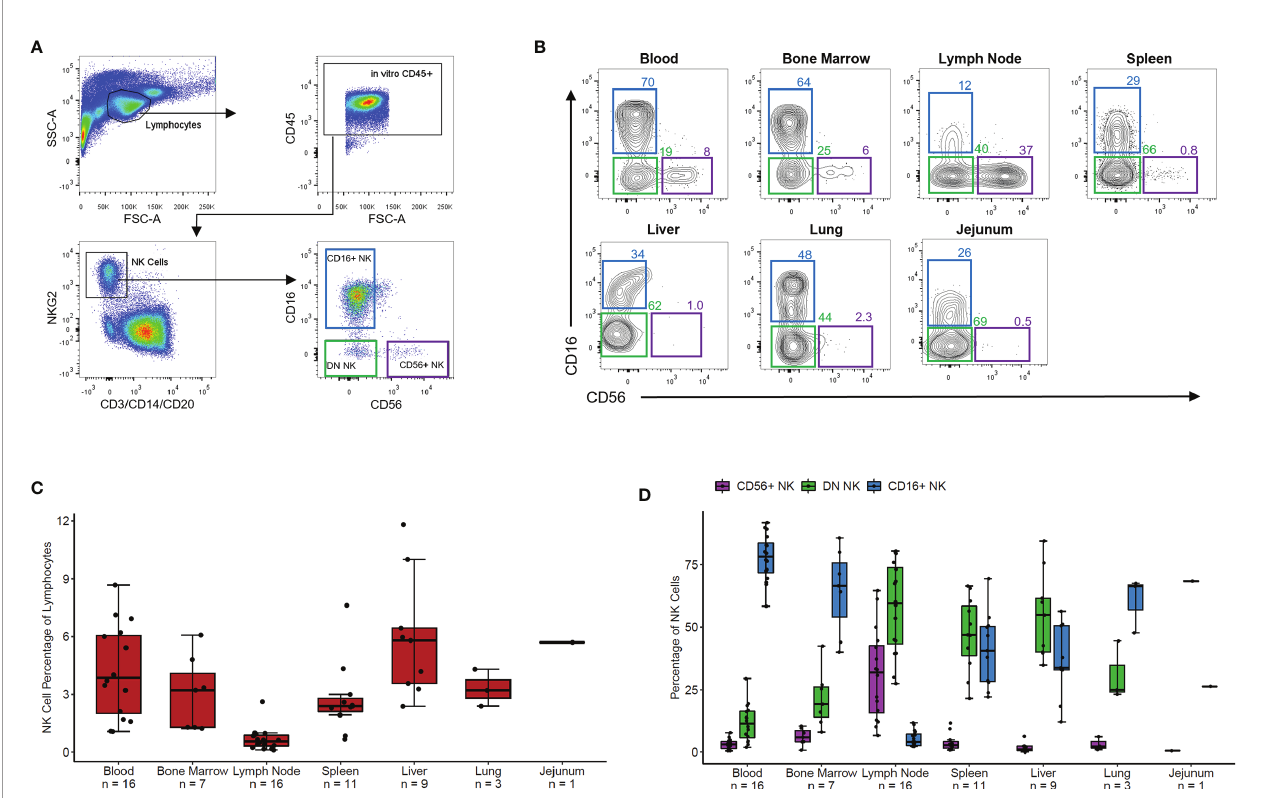
FIGURE 1 | NK phenotypes in rhesus blood and tissues. (A) Representative gating scheme of rhesus macaque NK cells de fi ned as CD3- CD20- CD14- NKG2+ followed by delineation of CD56+, CD56-CD16- (DN), and CD16+ NK cell subsets. (B) Representative fl ow plots of NK cell subsets in tissues. (C) Boxplot of the NK cell percentage of total lymphocyte for the seven tissues shown in panel (B) . (D) Boxplot showing the percentage of each NK cell subset of the total NK cell population for the seven tissues shown in panels (B, C) For boxplots, each data point within a tissue is from a different animal. Box shows interquartile range and black line shows median value. Whiskers extend to the largest and smallest values within 1.5 times the interquartile